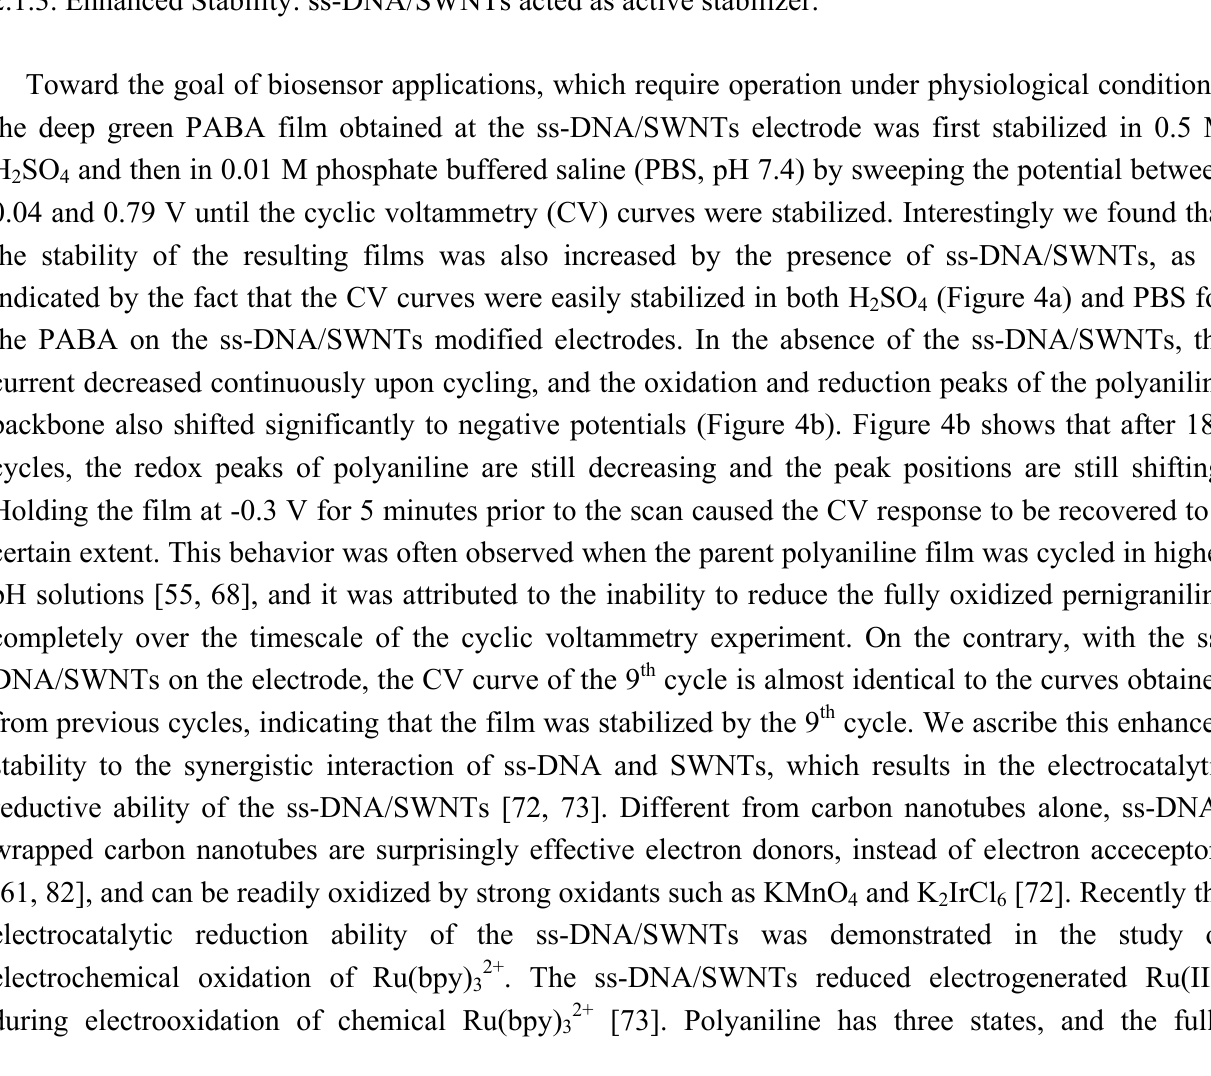
; (b) FTIR spectra of the 4 4